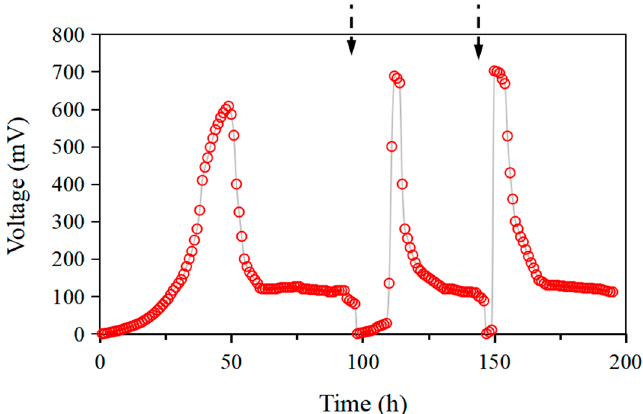
Figure 2. Voltage output of the AMDC (arrows indicate replacement of substrate solution).